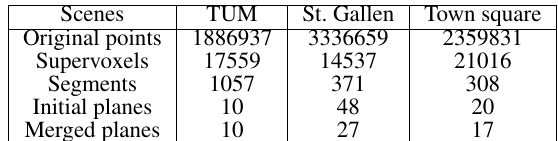
Table 2. Number of extracted planes.